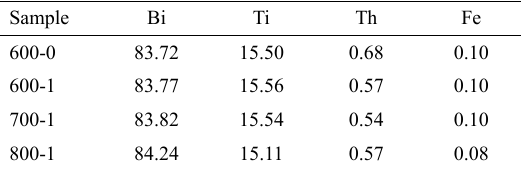
Table 2. Quantitative results of X-Ray fluorescence (% wt) for the samples.